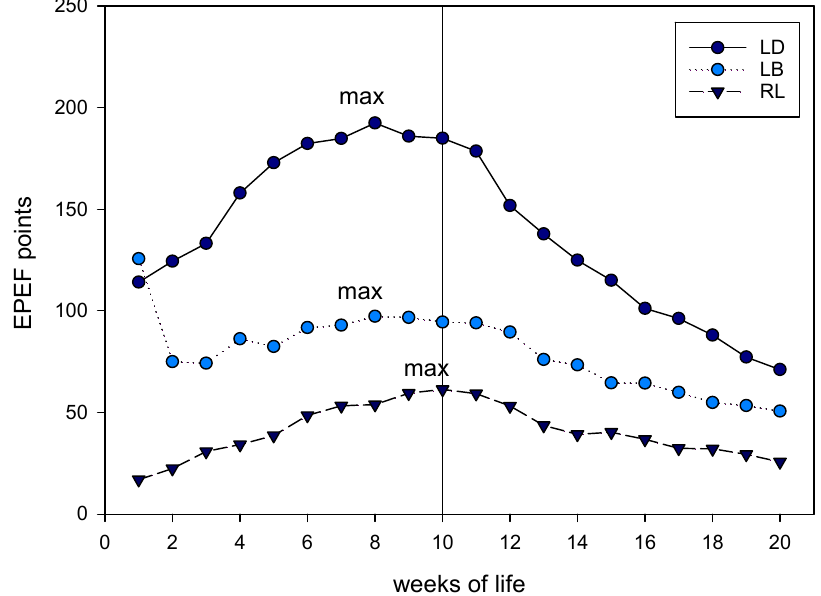
Figure 3. Calculated points of the European production efficiency factor (survival rate (100 – mortality) × live weight [kg bird − 1 ]/age [days] × FCR) × 100) for birds of all strains. Maximum points are marked (note that for LB the local maximum score is indicated, not the global maximum). Measures were taken from unsexed groups until week 10, when hens were removed from the flock and only 100 cocks / genotype